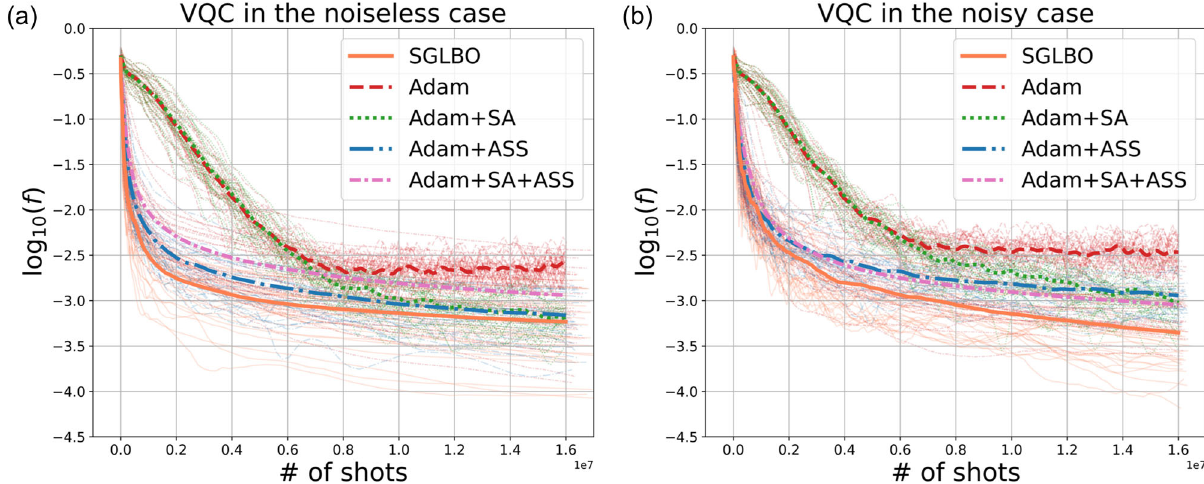
Fig. 6 Comparison of Adam with the suf fi x averaging technique (SA) and/or the adaptive shot strategy (ASS), in terms of the performance on the same VQC task as Fig. 4. The x - and y -axes are the same as Fig. 4. For each optimizer, the thin lines represent each run repeated twice from fi fteen different initial points, and the thick line represents the average of these thirty runs. In both the noiseless ( a ) and noisy ( b ) cases, the adaptive shot strategy improves the performance of the original Adam, but the SGLBO outperforms the others. This shows that the adaptive shot strategy is also useful in improving the accuracy of Adam, rather than a speci fi c technique for the